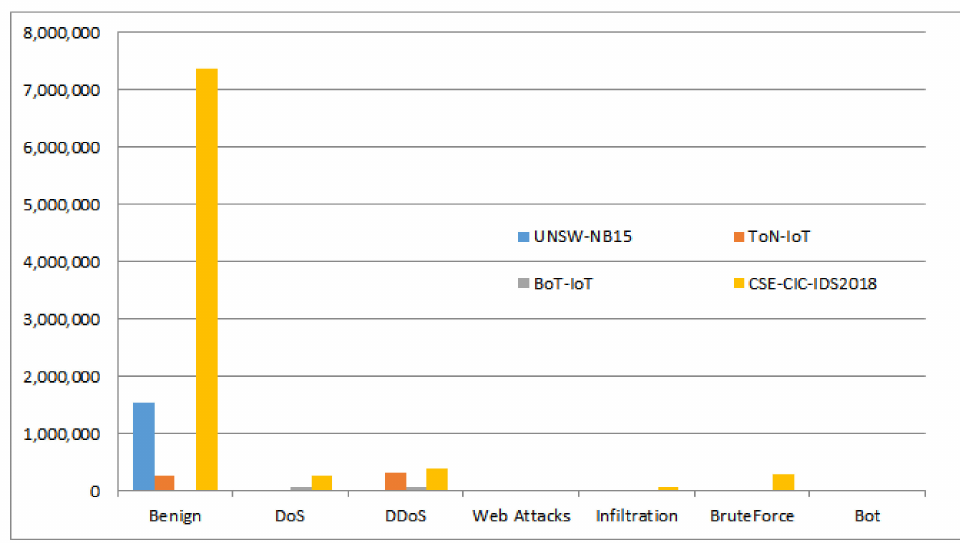
Figure 2. Summary of attacks covered by available